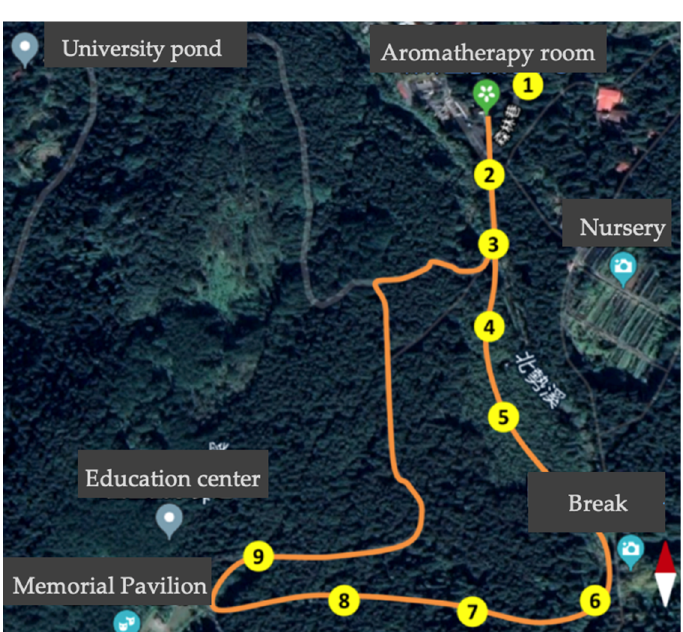
Figure 1. Map of forest therapy activities with